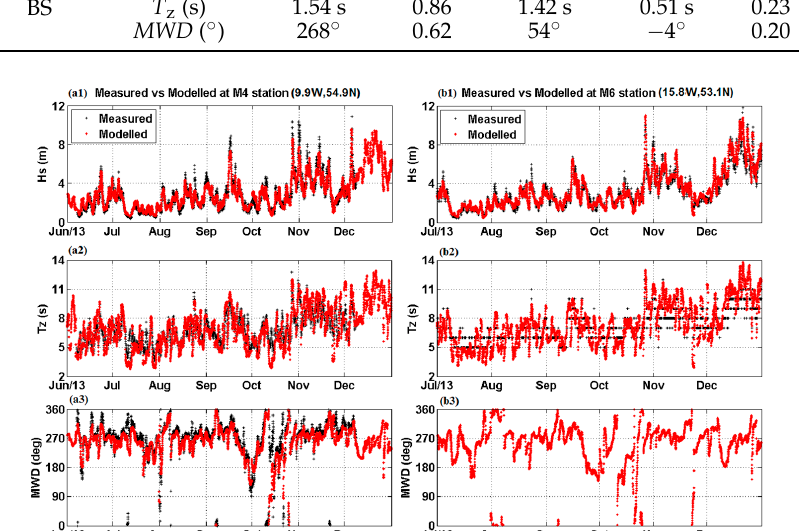
Figure 2. Comparison of modelled and measured data at ( a1 – a3 ) M4 and ( b1 – b3 ) M6 for 2013. 1 = H s , 2 = T z and 3 = MWD . Note: measured MWD was not available for M6.